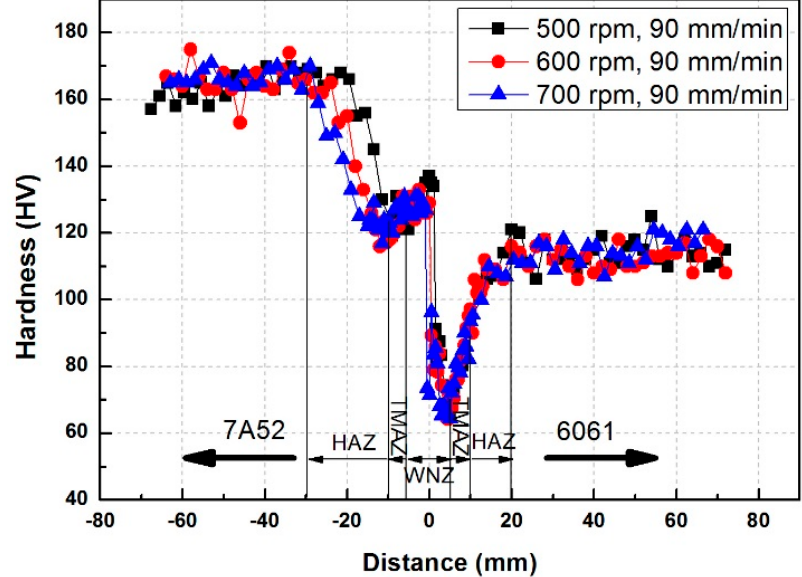
Figure 2. Microhardness profile along the middle section of the weld joint of T6-treated 7A52 and 6061 Al alloys at different rotational speed.